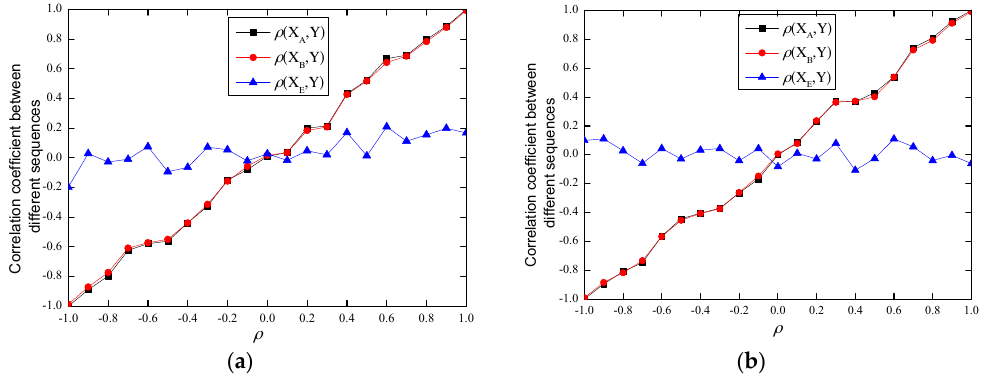
Figure 4. Theorem 2 validation. ( a ) indoor environments; ( b ) outdoor environments.